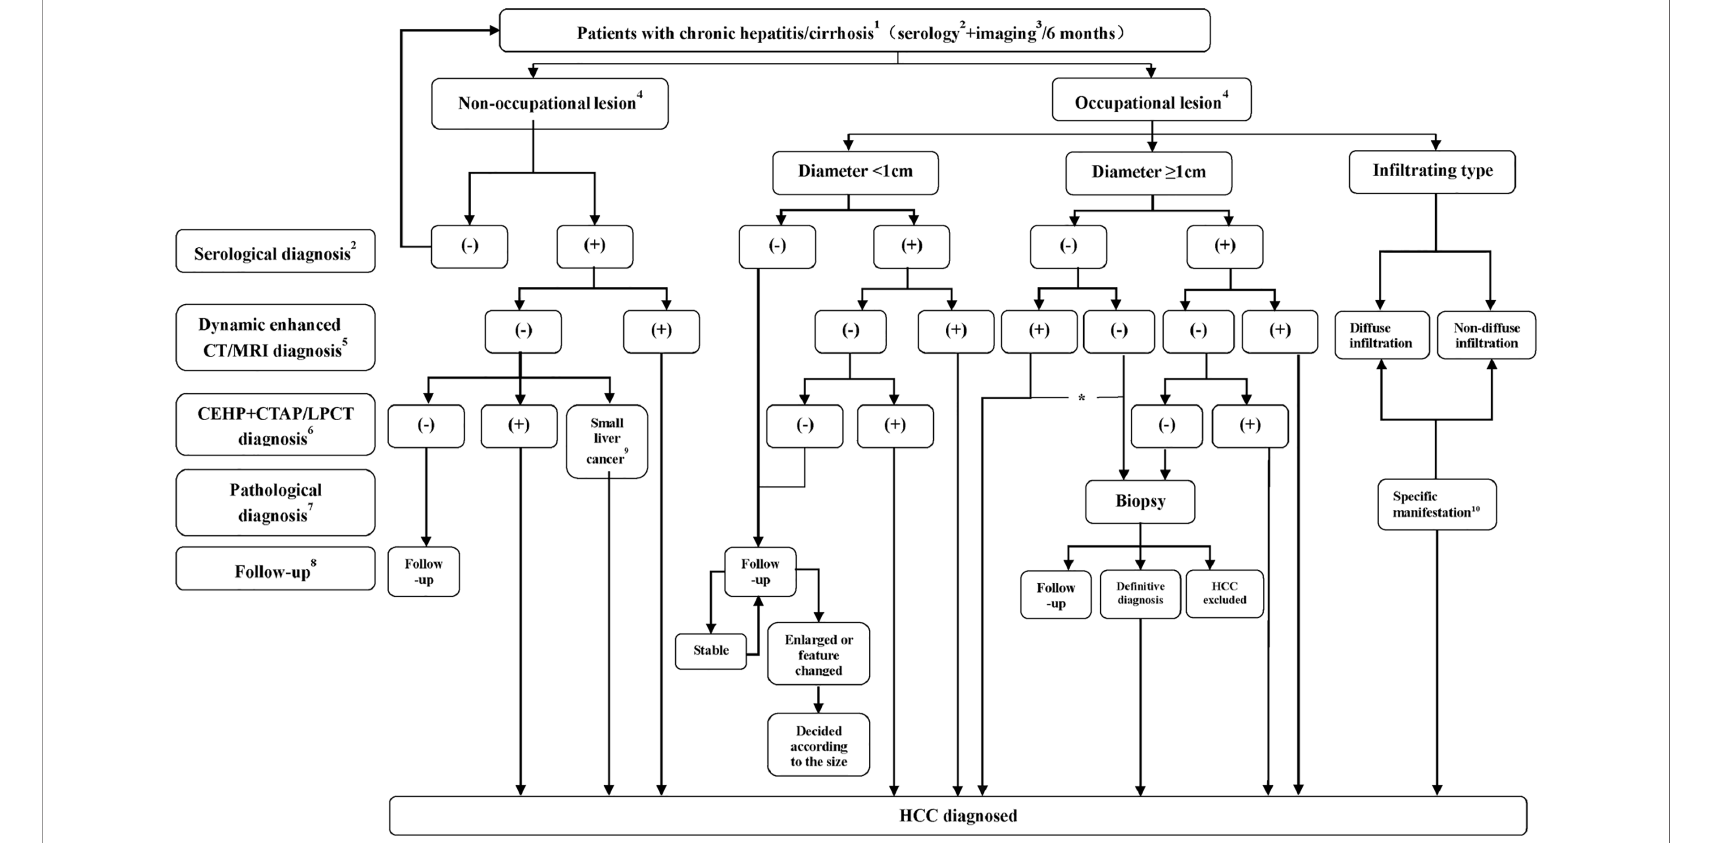
FIGURE 1 | Flowchart of HCC diagnosis. 1 The fl owchart is mainly applicable to the diagnosis of HCC patients with HBV and/or HCV infection or a liver cirrhosis background related to various causes. For intrahepatic space-occupying lesion patients without hepatitis or a cirrhosis history, diagnosis is usually made by using biopsy; 2 or serological diagnosis including AFP, AFP-L3, or DCP detection. Serological diagnosis ( + ) refers to AFP ≥ 400 µg/L for more than 1 month or ≥ 200 µg/L for 2 months, DCP > 40 mAU/mL or AFP- L3/AFP>15%; 3 including ultrasound or preliminary CT/MRI examination, with ultrasound more commonly performed; 4 No nodule refers to no nodule detected in the liver during imaging follow-up, and intrahepatic nodule refers to a nodular lesion detected in the liver during imaging follow-up; 5 Signi fi cant enhancement during the arterial phase and washout during the portal venous phase or delayed phase; 6 Nodule enhancement in CTHA, fi lling defect in CTAP and lipiodol deposits in the nodules 2 to 3 weeks after lipiodol injection revealed by Lp-CT; 7 Biopsy (-) does not rule out the possibility of HCC, which still requires close follow-up; 8 Serological plus imaging monitoring is performed every 3 months during the fi rst 2 years, and the patient is considered stable if there is no signi fi cant change and is then followed up at 6 months intervals; 9 Micro-HCC is de fi ned as follows: 1. Lesion diameter ≤ 0.5 cm; 2. Clinically elevated AFP (AFP ≥ 400 µg/L for more than 1 month or ≥ 200 µg/L for 2 months); 3. Lesions that were detected by CTAP/CTHA or/and present as spotted lipiodol deposits in Lp-CT or TACE; 4. AFP decreased or returned to a normal level after Lp-CT or TACE; 10 Refers to nondiffuse in fi ltration and diffuse distribution of lesions with an unclear boundary in the liver. T1 WI shows an uneven, slightly low signal, and T2 WI shows a slightly high signal, limited diffusion, and uneven or miliary enhancement or slight enhancement in the arterial phase and no washout in the portal venous phase, which instead would demonstrate continuous enhancement; *For nodules with a diameter of more than 1 cm with typical imaging manifestations, when serological diagnosis is negative, the lesions should be distinguished from primary HCC and other rare pathological types. If the patients choose nonsurgical treatment, a needle biopsy is